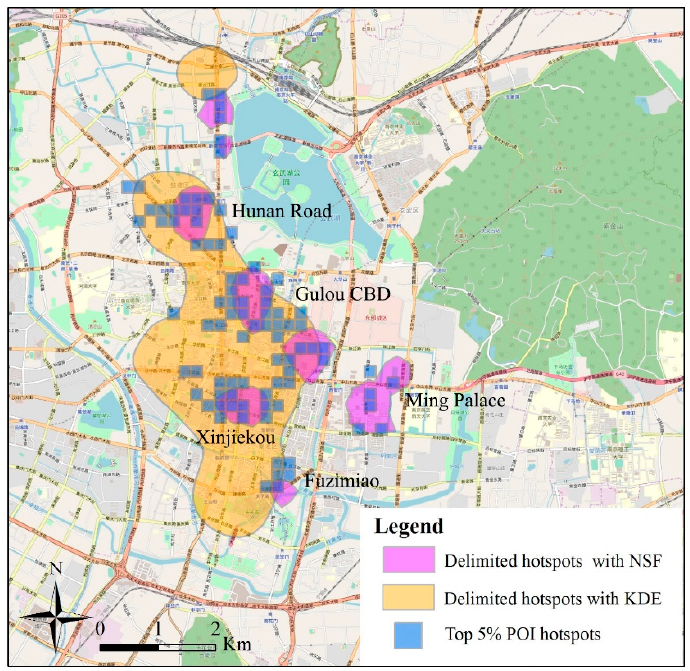
Figure 13. The overlap analysis between the delineated results and the reference POI hotspots.